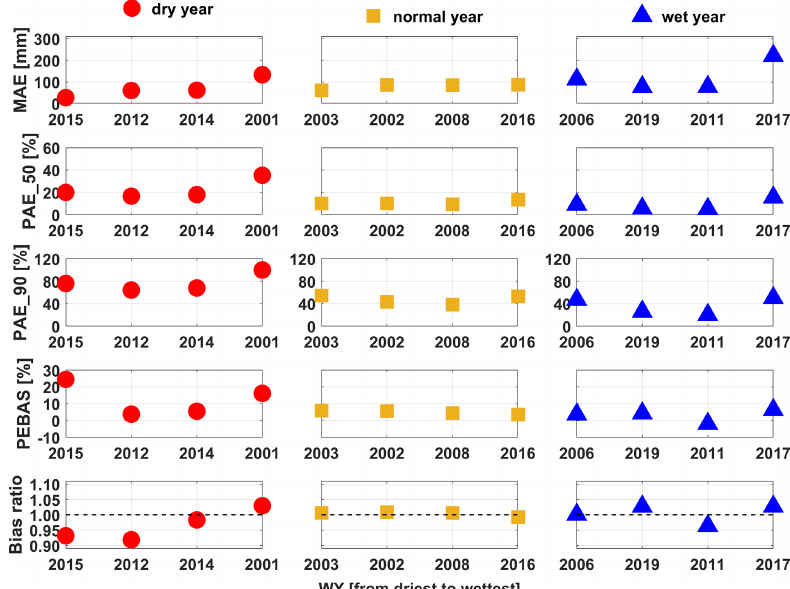
Figure 5. MAE (mm; first row), PAE_50 (%; second row), PAE_90 (%; third row), PEBAS (%; fourth row) and bias ratio (slope; fifth row) of the DNN-based estimated 1 April SWE for the 4 driest years (red dots; WY2015, 2012, 2014 and 2001), 4 normal years (yellow square points; WY2003, 2002, 2008, and 2016) and 4 wettest years (blue triangle points; WY2006, 2009, 2011, and 2017) from WY2000 to